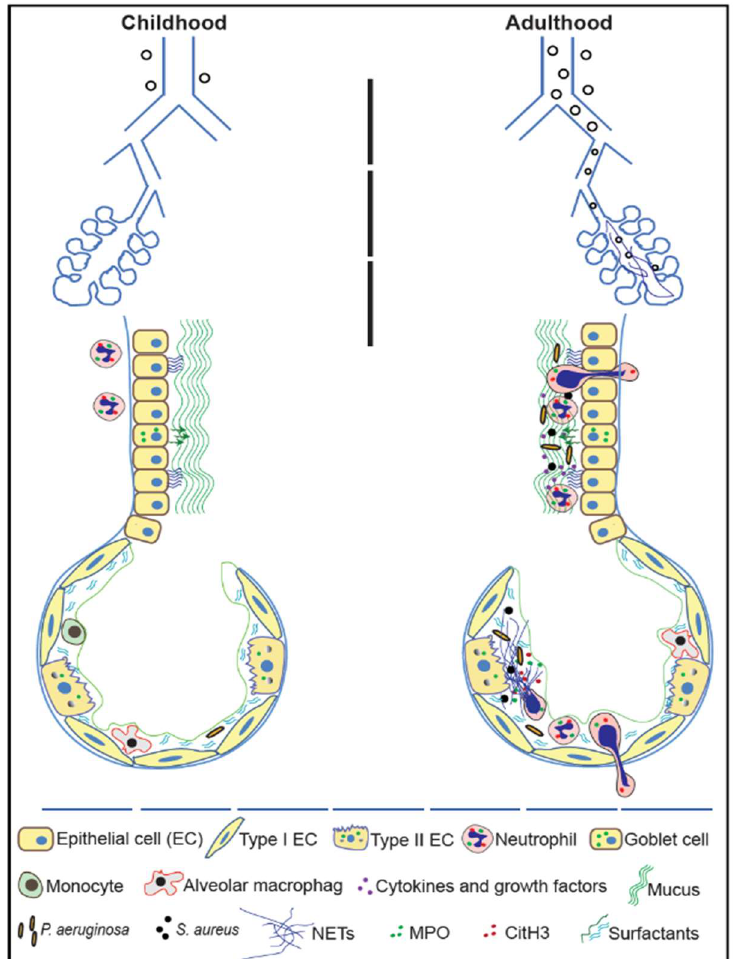
Figure 1. Airway alterations and neutrophil extracellular traps (NET) formation in Cystic Fibrosis airways. In fetal stages and early childhood, neutrophilic inflammation at the peribronchial regions is identifiable in patients with CF. In early childhood, CF airways have excess mucus and obstructive